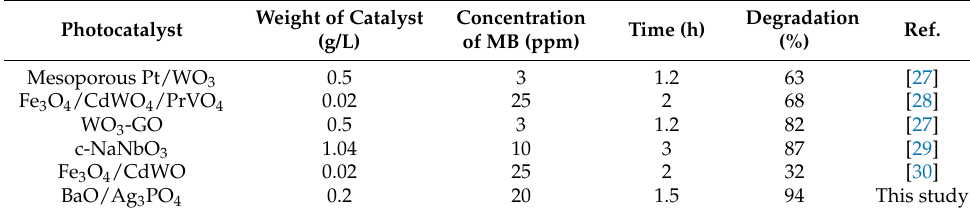
Table 1. Removal of MB under visible light, with various photo catalysts. Photocatalyst